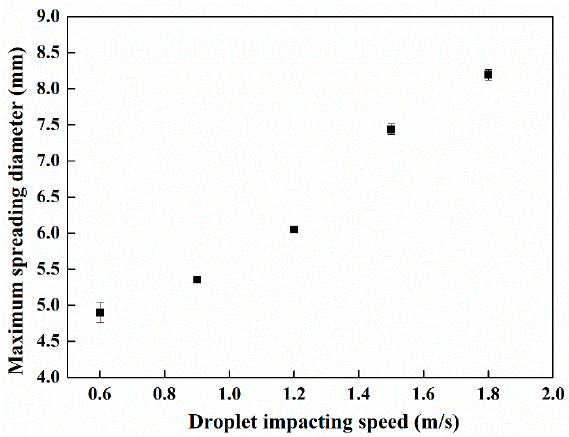
Figure 8. The maximum spreading diameter of the droplet with different impacting speed.